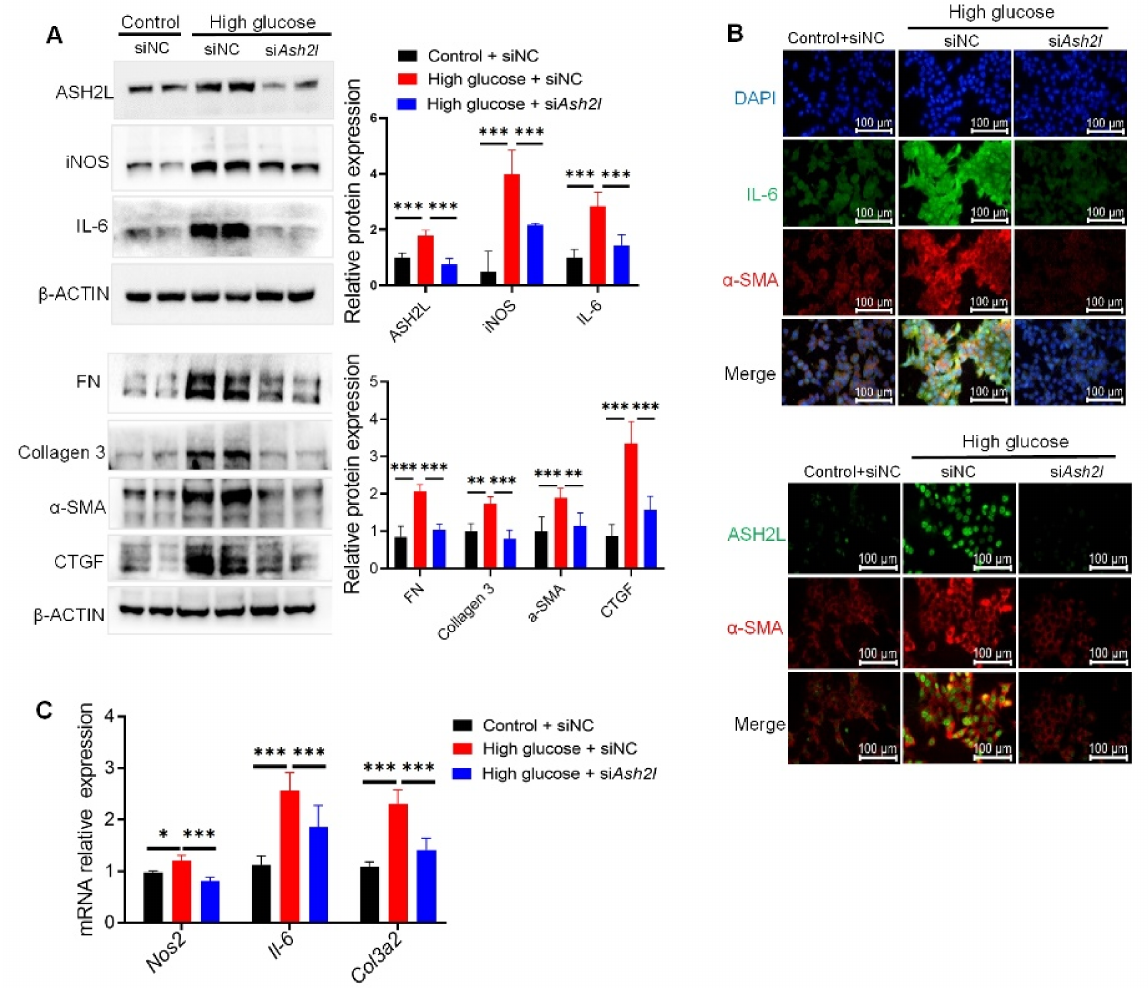
Figure 2. Knockdown of ASH2L decreases fibrosis and inflammation in mesangial cells. ( A ) Western blot analysis of ASH2L, fibrosis markers (FN, Collagen 3, α -SMA, and CTGF), and inflammatory mediators (iNOS, and IL-6) expression in SV40-MES-13 cells treated with or without 33 mM D- glucose for 24 h after being transfected with negative control (siNC) or ASH2L small interfering RNA (si Ash2l ). Data from at least three independent experiments are shown as mean ± S.D, ** p < 0.01, and *** p < 0.001. ( B ) Immunofluorescence staining of ASH2L, α -SMA, and IL-6 in SV40-MES-13 cells treated with or without 33 mM D-glucose for 24 h after transfection with siNC or si Ash2l . ( C ) Quantitative RT-PCR analysis of Nos2, Il-6, and Col3a2 in SV40-MES-13 cells treated with or without 33 mM D-glucose for 24 h after transfection with siNC or si Ash2l . Data from at least three independent experiments are shown as mean ± S.D, * p < 0.05, and *** p <